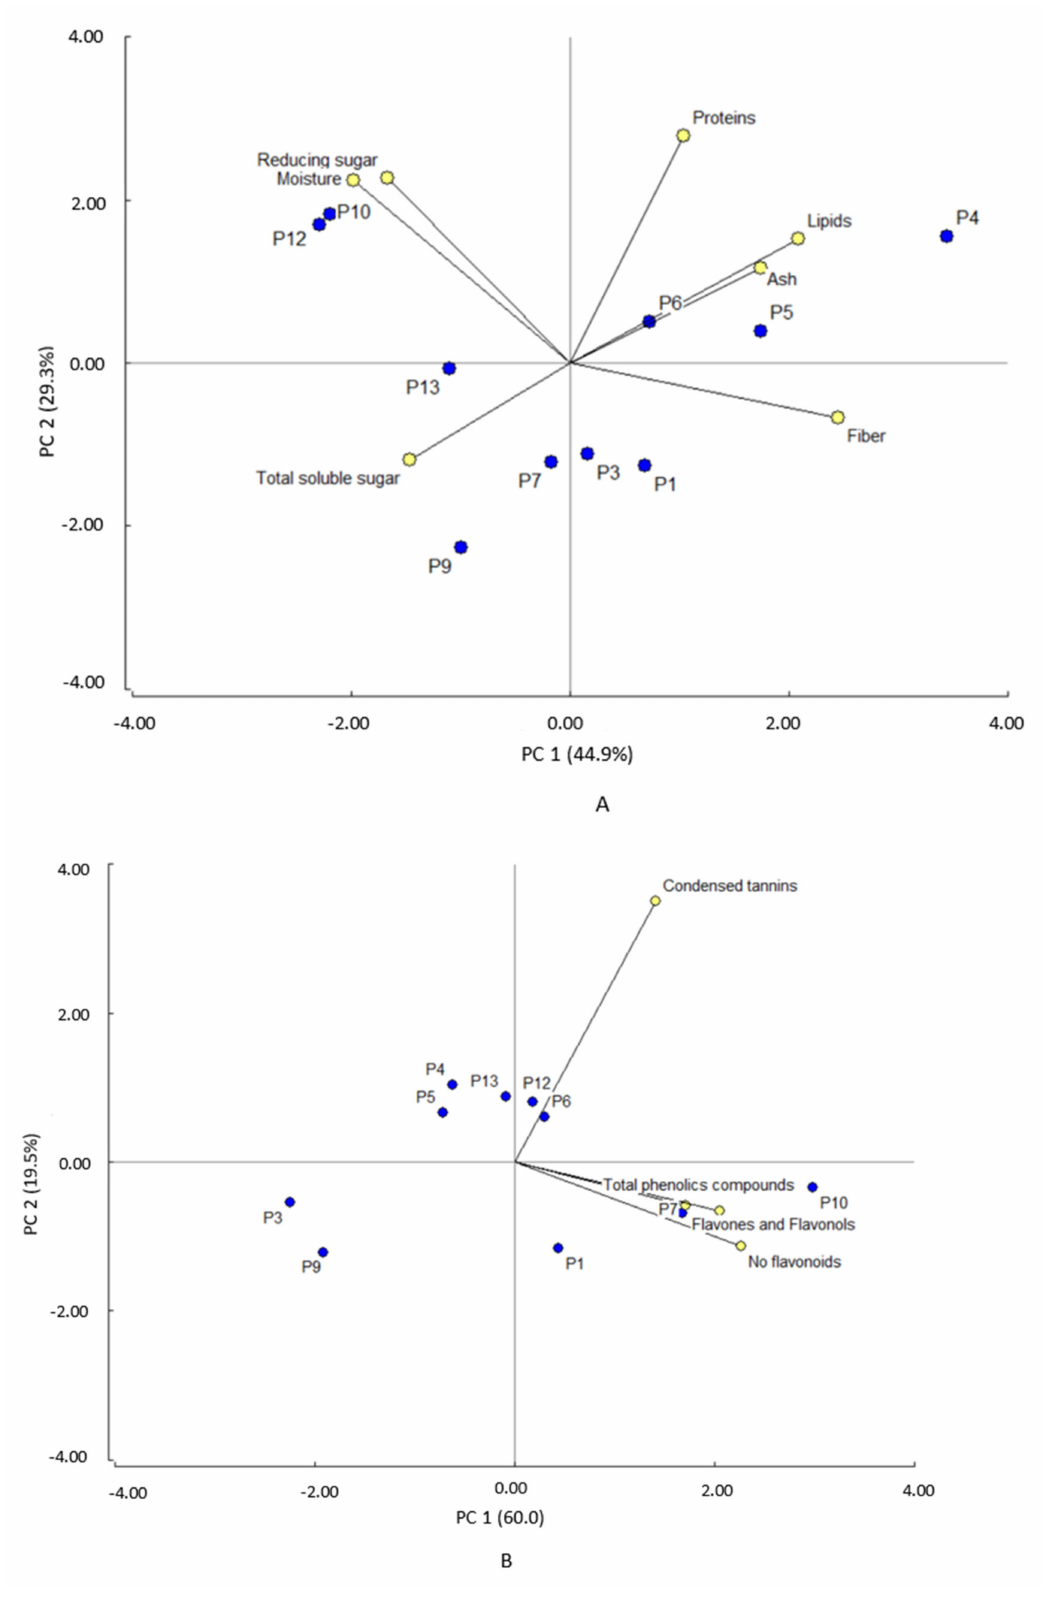
Figure 3. Principal component analysis for ( A ) proximal components and ( B )